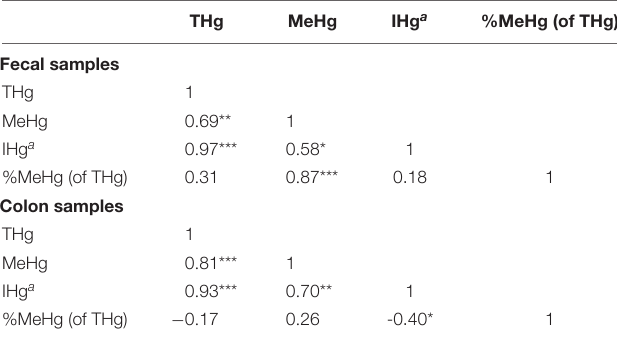
TABLE 3 | Spearman’s correlation for mercury species ( n = 16